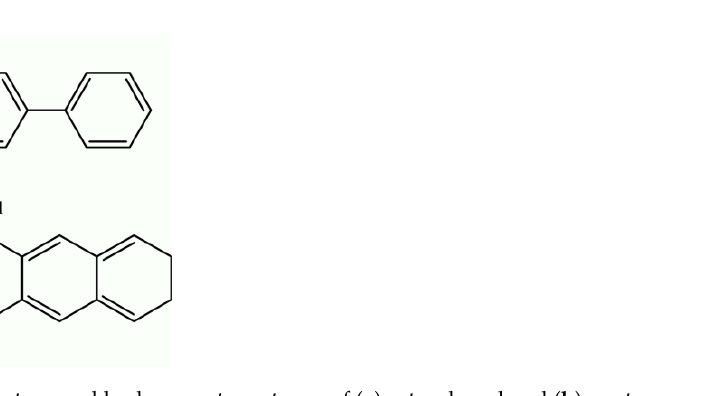
Figure 8. Molecular structure and hydrogen atoms types of ( a ) p-terphenyl and ( b ) pentacene. The 1 H NMR spectra of pure, 0.01 wt.%, and 0.1 wt.% pentacene-doped p-terphenyl